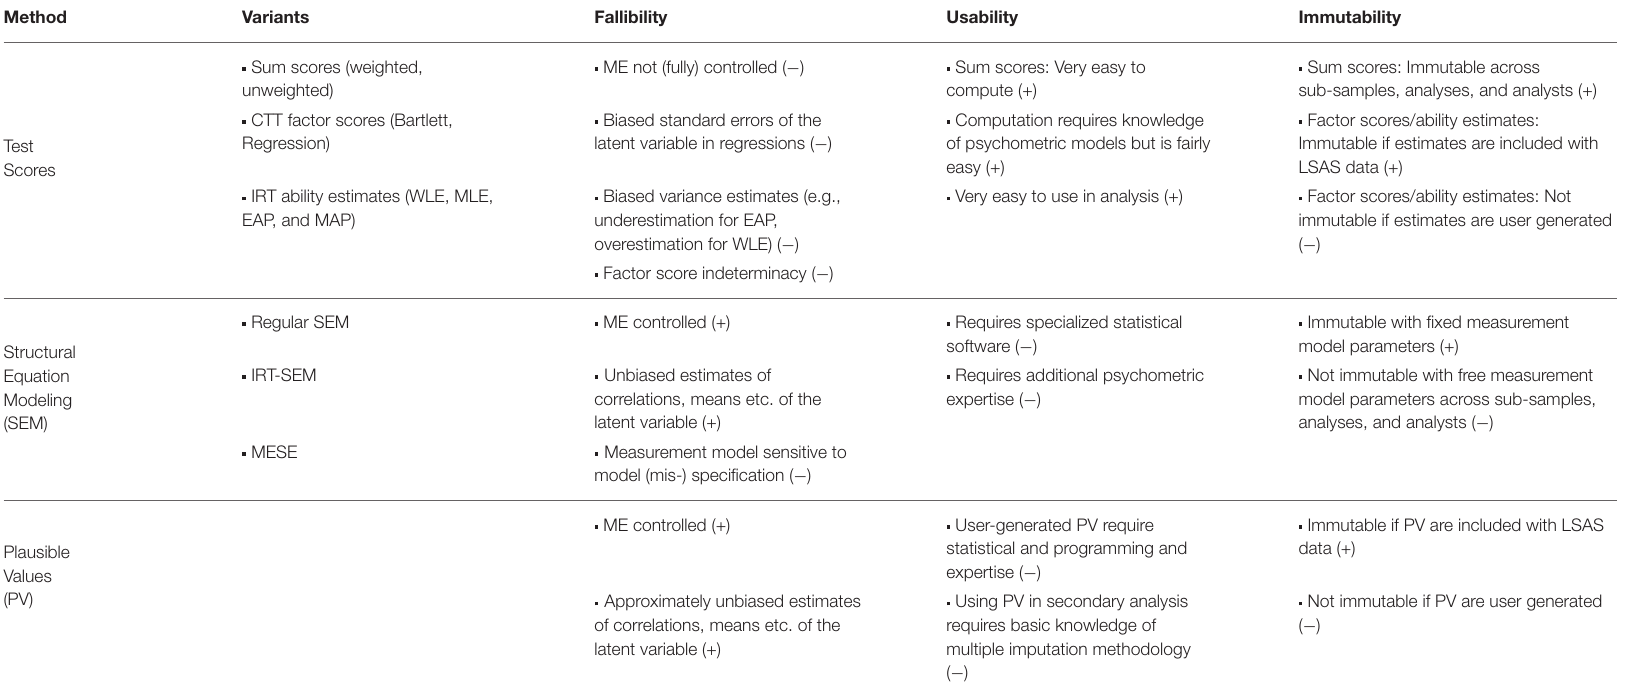
TABLE 1 | Evaluation of three main approaches to analyzing skill